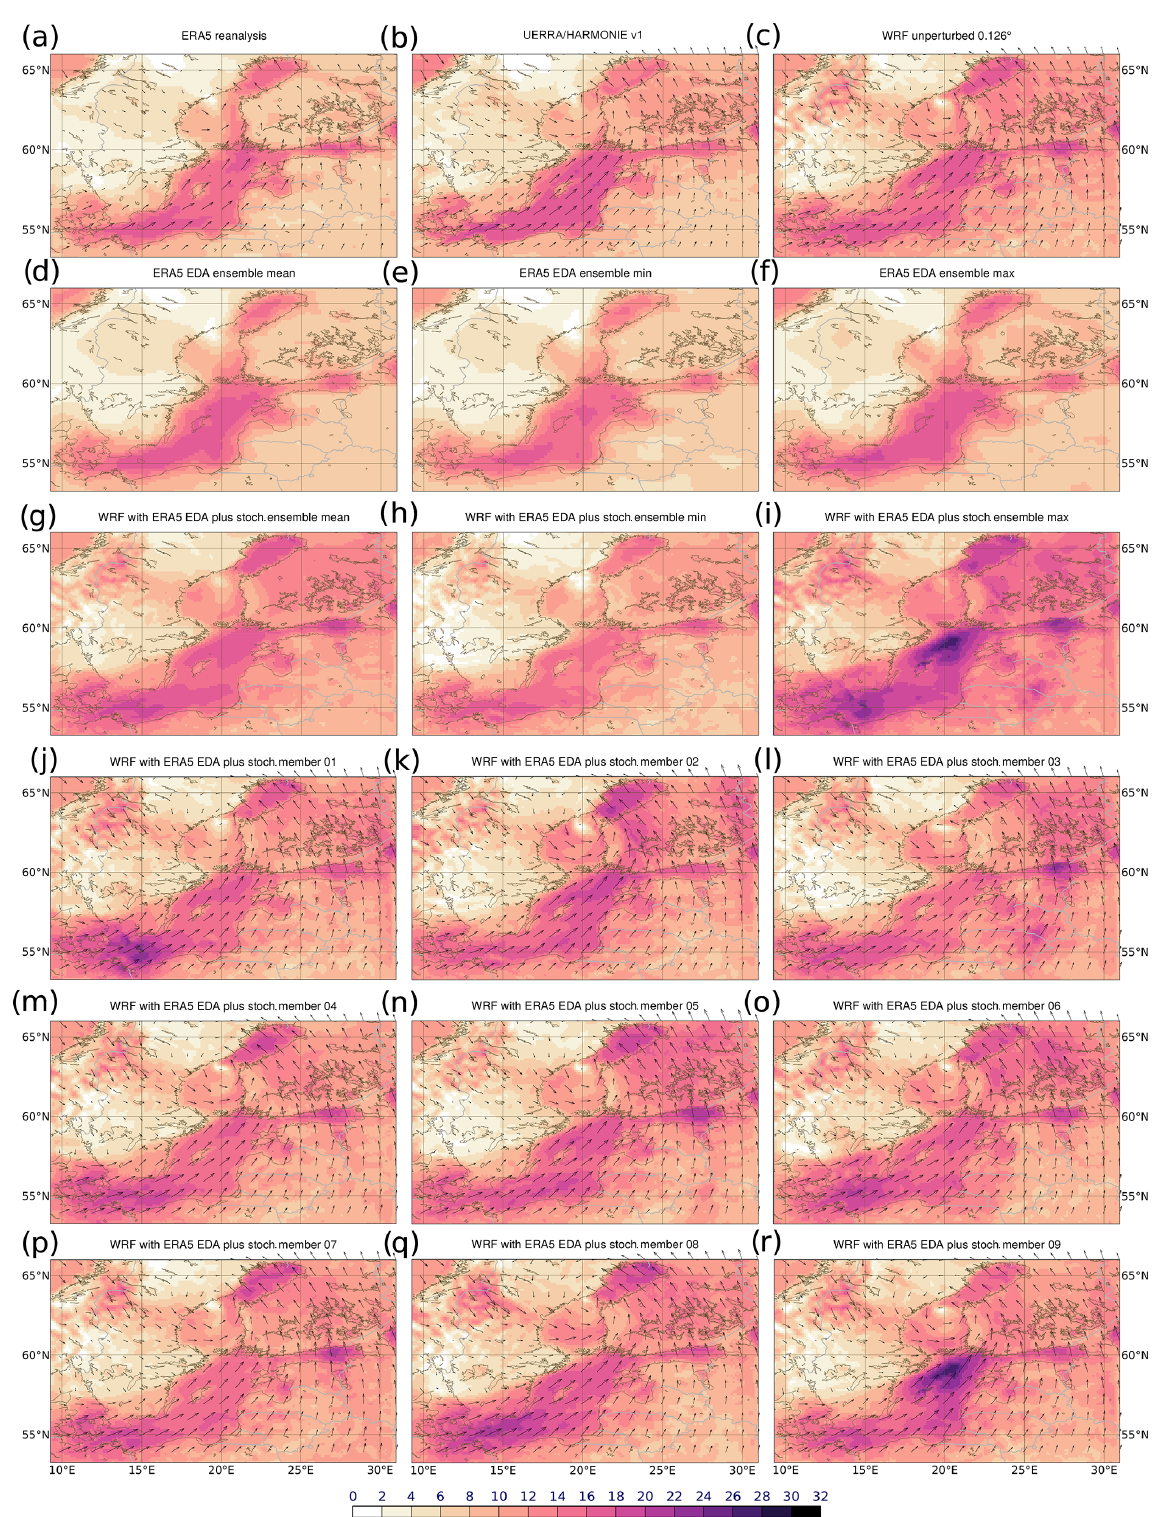
Figure 4. WRF ensemble approach number five generated by starting the 10 members from 10 ERA5 EDA members at 21 February 2002 12:00UTC plus stochastic perturbations SPPT and SKEB. Shown are results for 23 February 2002 09:00UTC. (a) The ERA5 reanalysis; (d) ERA5 EDA ensemble mean, (e) minimum, and (f) maximum; (c) WRF unperturbed; (g) WRF ensemble mean, (h) minimum, and (i) maximum; (b) UERRA/HARMONIE-v1; and (j–r) nine perturbed WRF members are shown. Wind speed (ms − 1 ) and direction are shown as